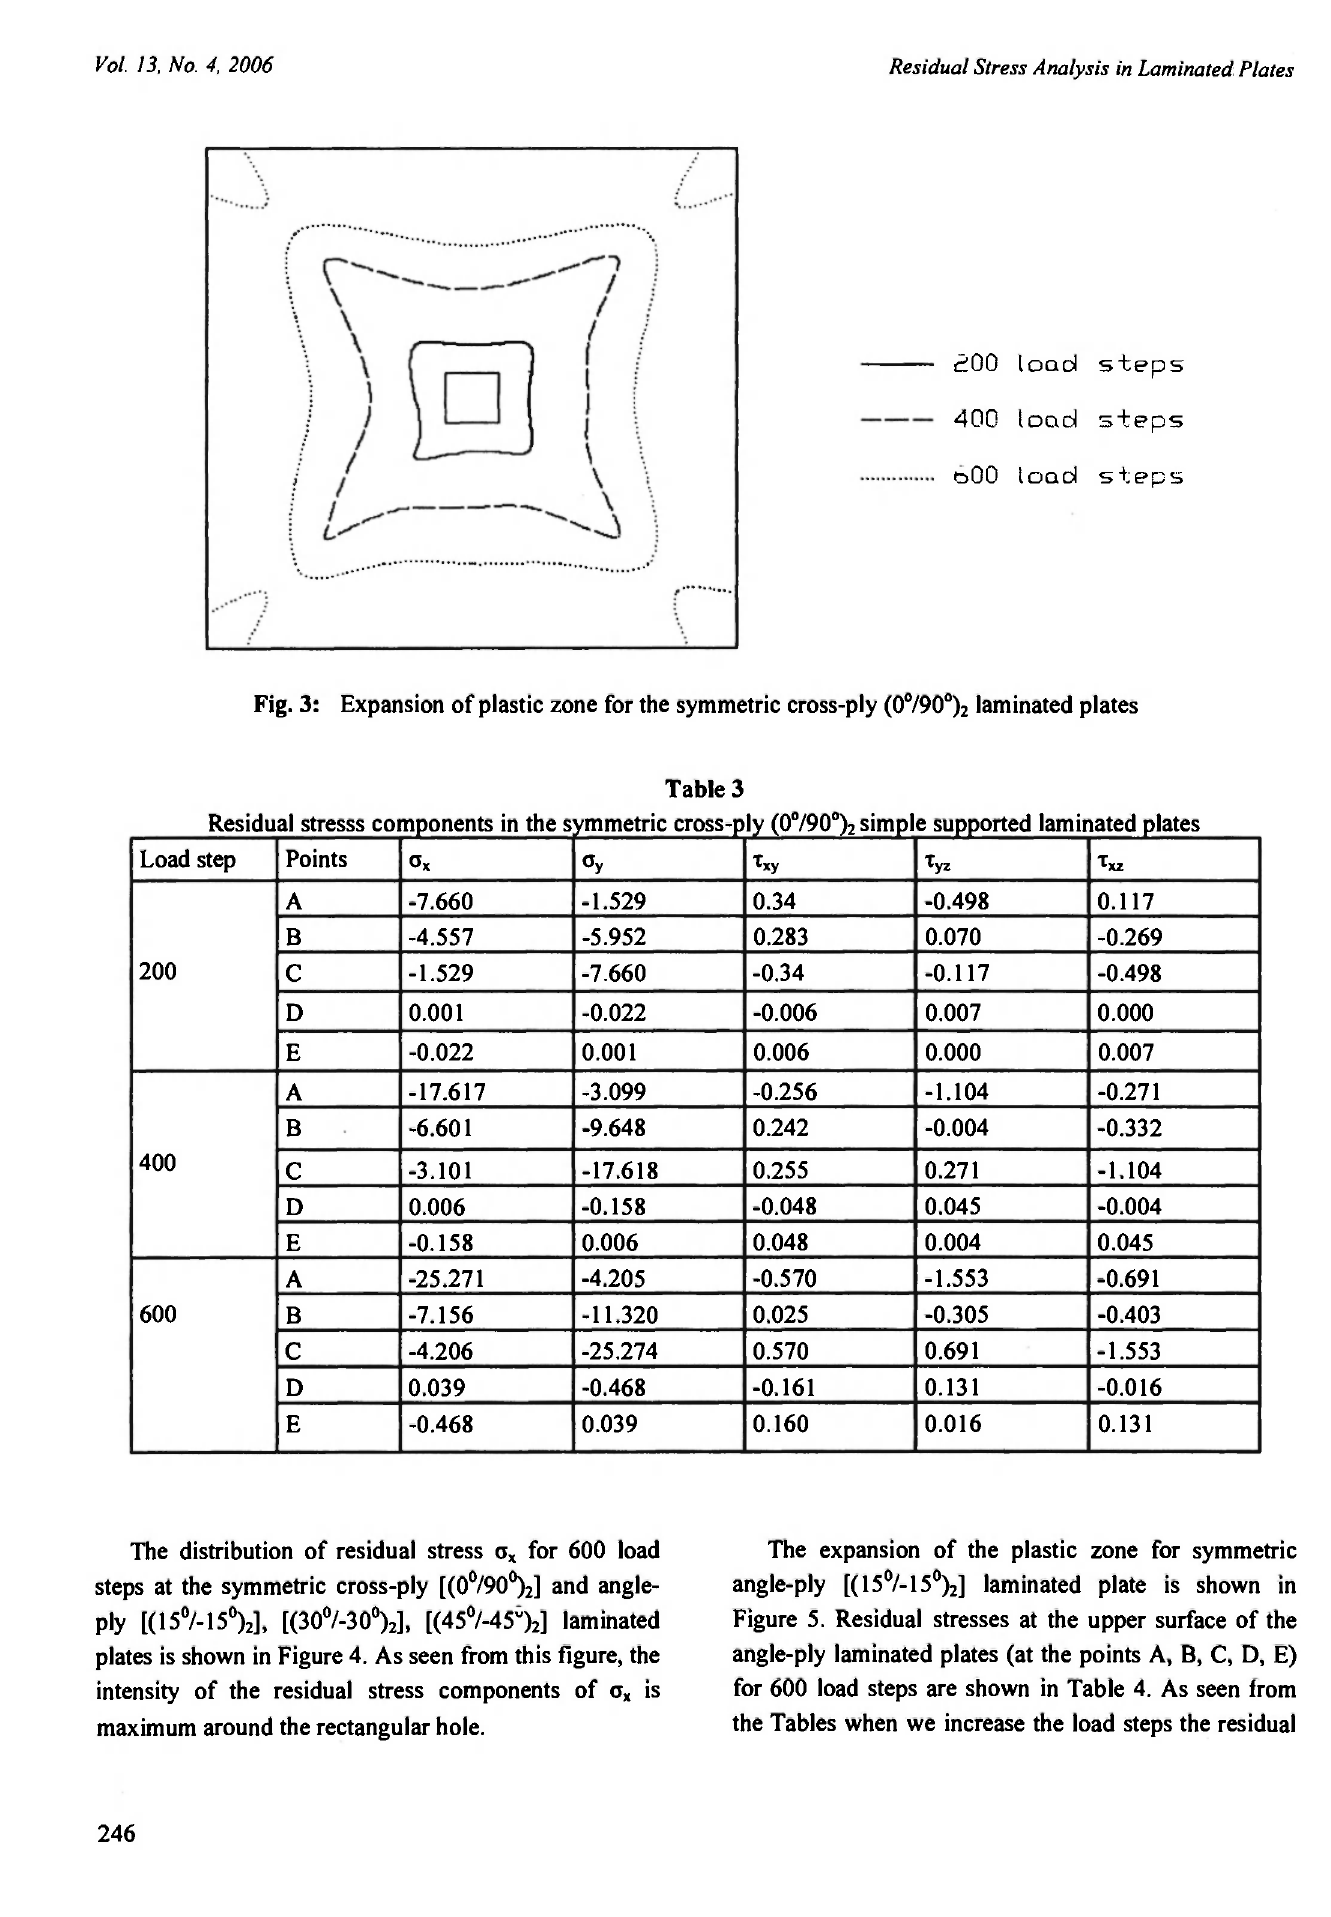
Fig. 3: Expansion of plastic zone for the symmetric cross-ply (0°/90 o ) 2 laminated plates